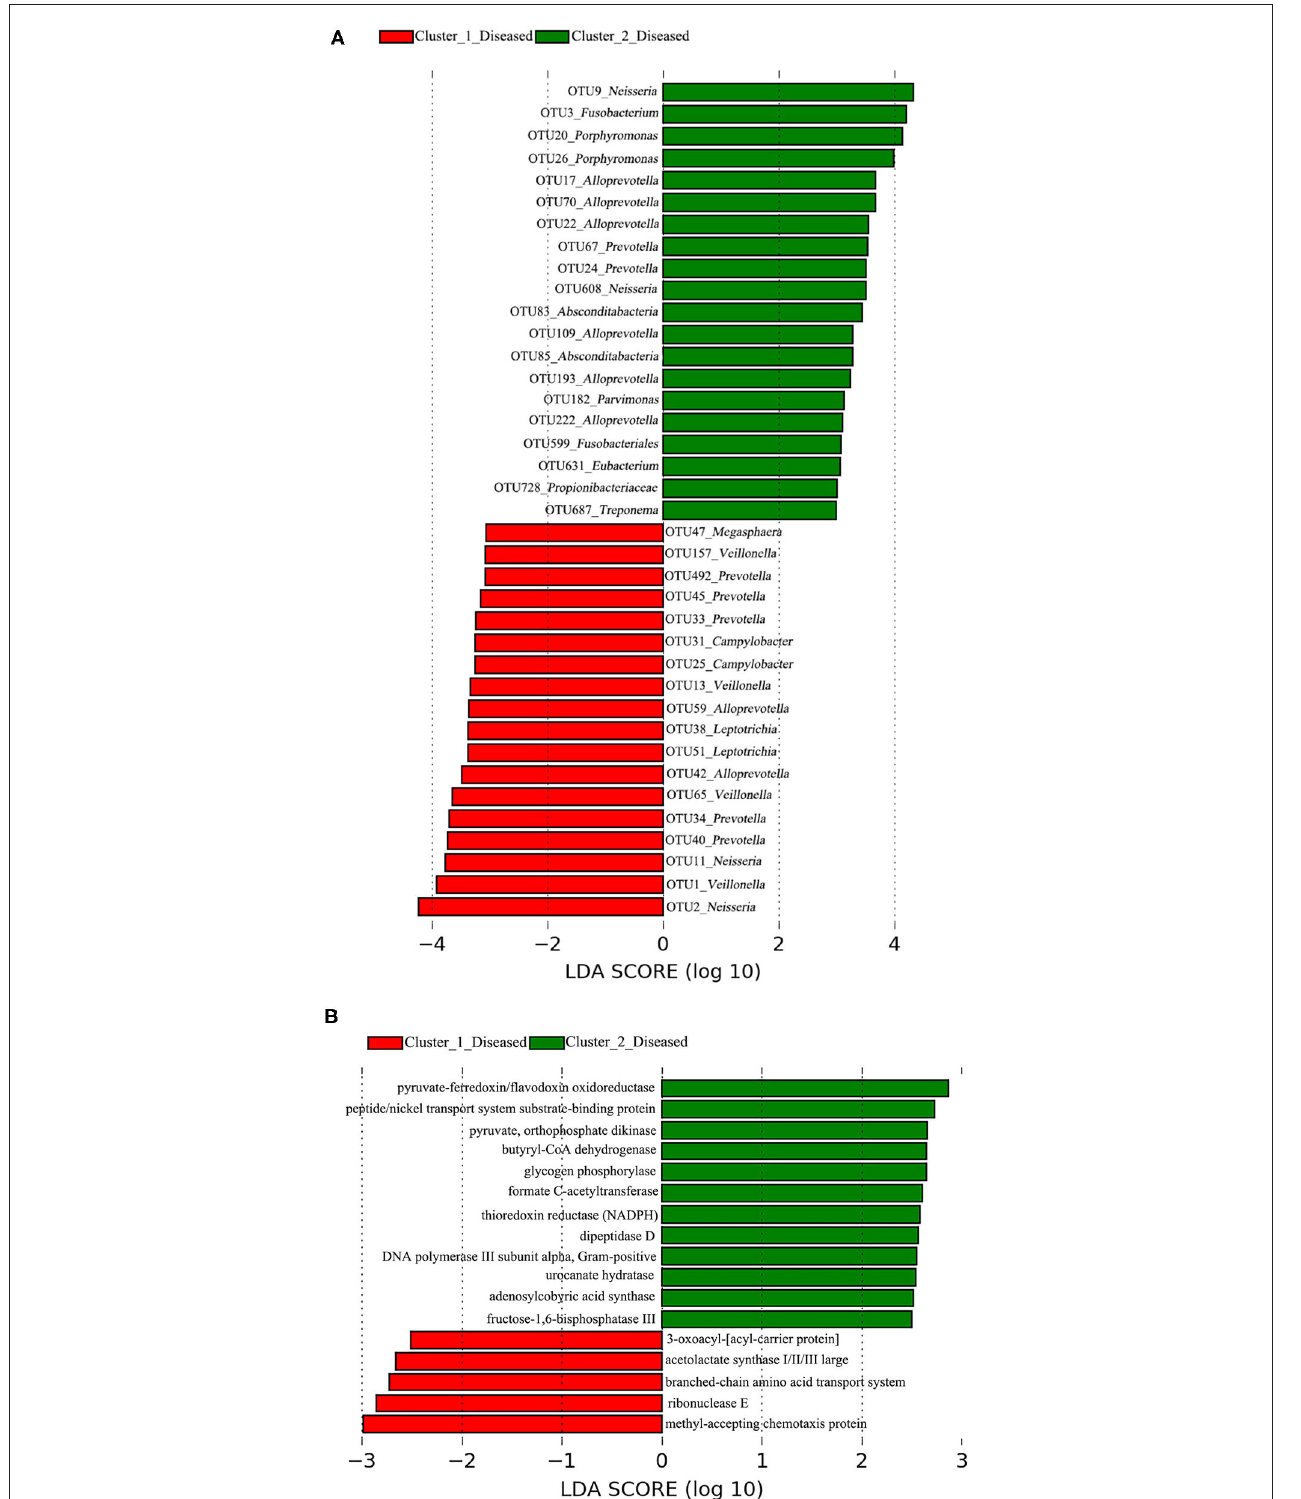
FIGURE 2 | Linear discriminant analysis (LDA) effect size (LEfSe) determined the (A) operational taxonomic units (OTUs) and (B) functional metabolites associated with each of the two clustered OP microbiotas of H7N9 patients.